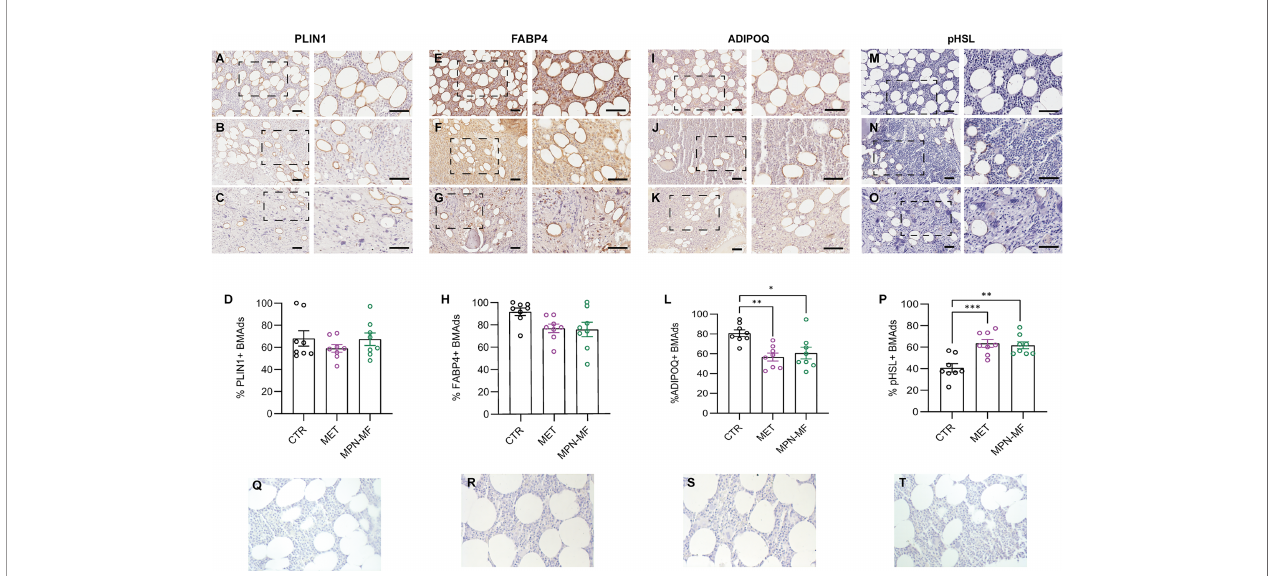
FIGURE 2 | Representative images of PLIN1-, FABP4-, ADIPOQ- and p-HSL-immunostained sections from CTR (A, E, I, M) , MET (B, F, J, N) and MPN-MF (C , G , K , O) bone biopsies. The right panels of each image illustrate the zoomed boxed area. Scale bars: 50 µm. Graphs in (D , H , L , P) represent the quantitative analysis of each immunostaining. Negative technical controls in which primary antibodies were omitted are shown in panels (Q – T) . * p < 0.05, ** p < 0.01; *** p <